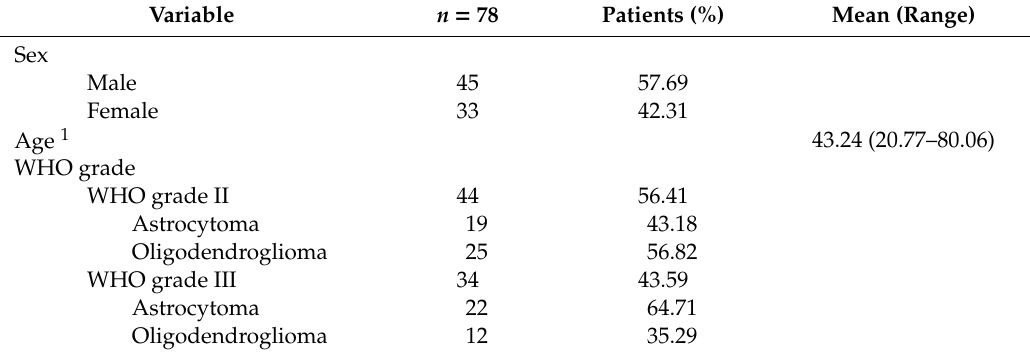
Table 1. Clinical data of patients with IDH-mutant (IDH mut ) primary lower-grade glioma.